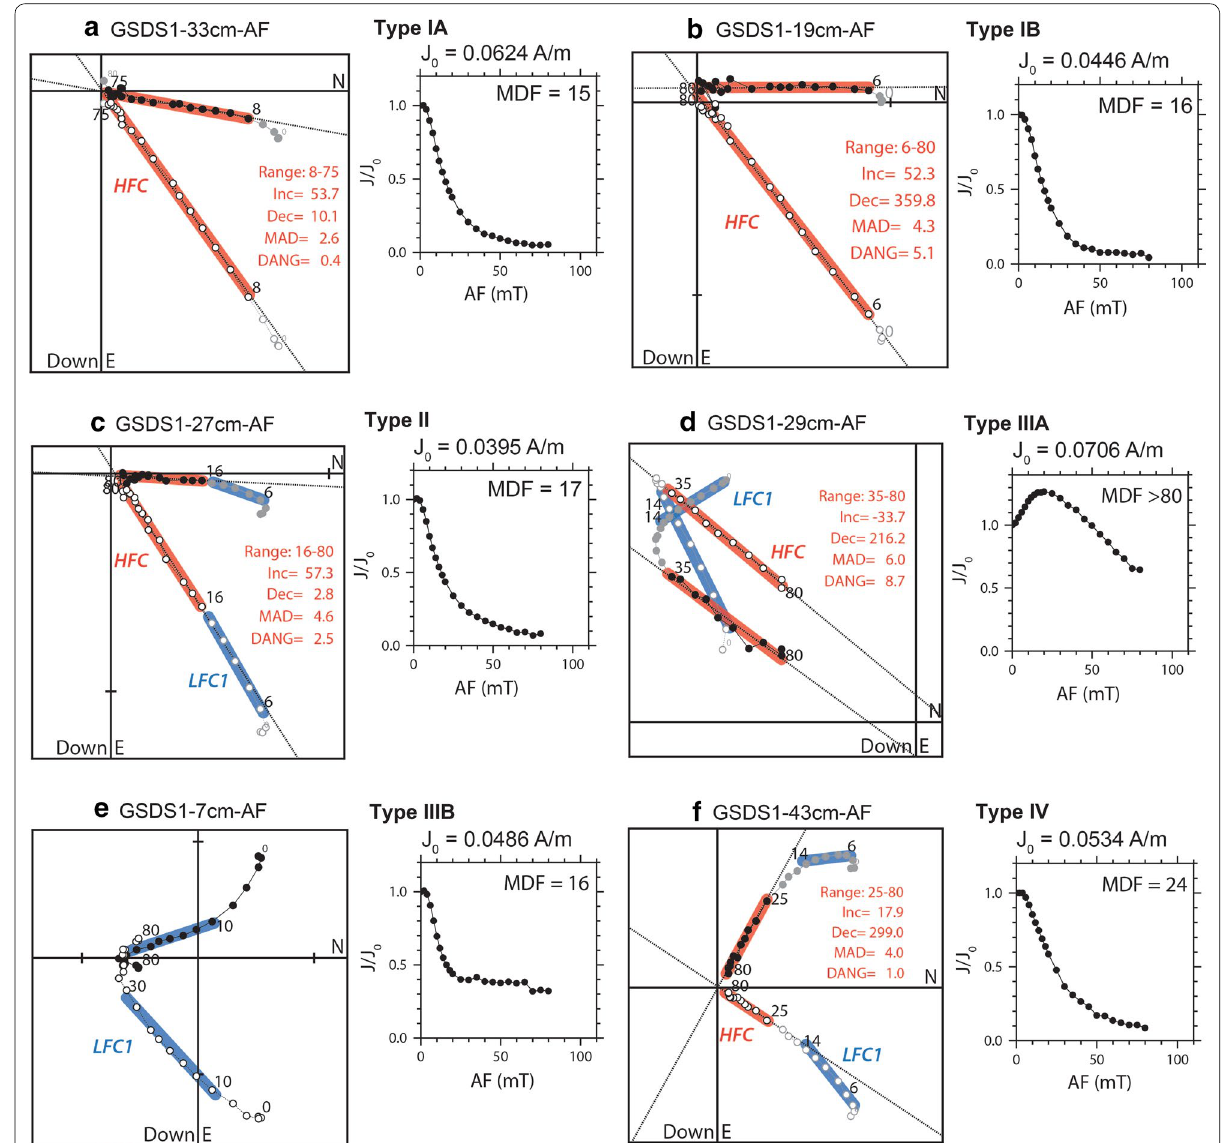
Fig. 3 Typical stepwise AF demagnetization results of NRMs for the first‑sampled (GSDS1) specimens, individually displayed on the orthogonal vector diagram (Zijderveld 1967), illustrating the HFC (red bar) and LFC1 (blue bar) segments (see text for details), with the associated NRM intensity decay curve. A characteristic (HFC) direction determined by the PCA (Kirschvink 1980) without anchoring the origin is shown. On the Zijderveld diagram, open (closed) dots indicate the end‑points of NRM vectors in the vertical (horizontal) plane at each AF level. For details of the respective types of the results, a to f , see text (“Paleomagnetic results”